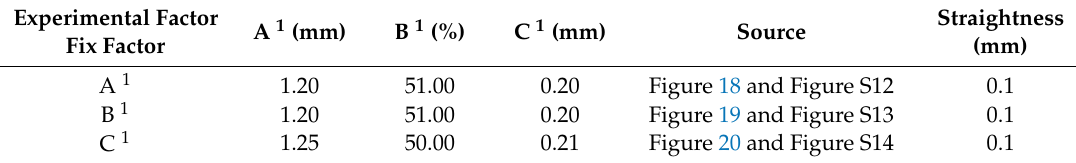
Table 5. Value of Experimental Factor for Straightness X2.